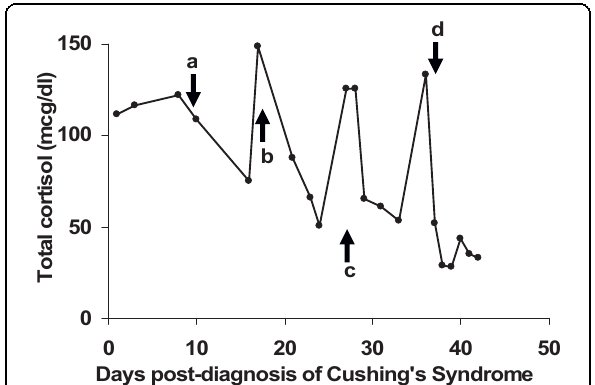
Figure 1 Plasma cortisol levels during the patient ’ s hospital course and treatment. a = ketoconazole 200 mg PO BID, b= ketoconazole 400 mg BID, c= ketoconazole 400mg TID, d= metyrapone 500 mg